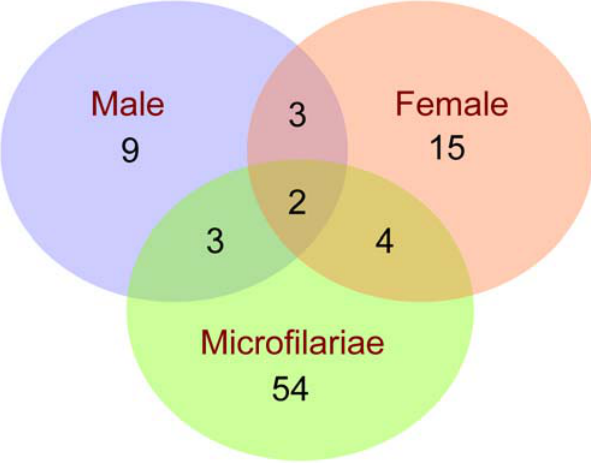
Figure 5. Distribution and functional classification of Wolbachia ES proteins. Proteins identified in the ES were searched against the Wolbachia database and a total of 91 were identified in the ES of Brugia malayi . The pie-chart represents the percentage of Wolbachia proteins identified from all of the stages, plotted on as a function of their classification. Only a single annotation was assigned to a given protein. All unknown and hypothetical proteins have been classified as uncharacterized. (Note: Metabolism includes amino acid, carbohydrates, nuclear and energy metabolism.)